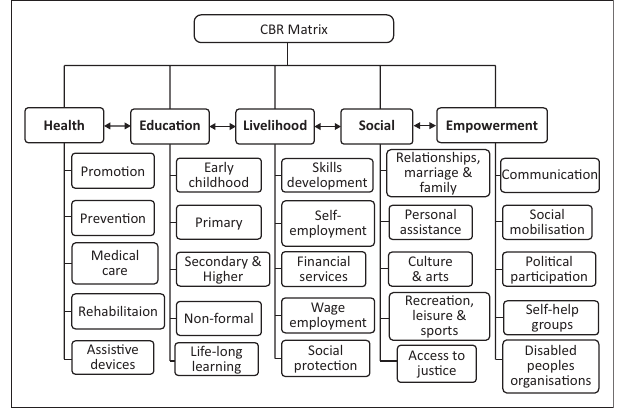
FIGURE 1: Community Based Rehabilitation